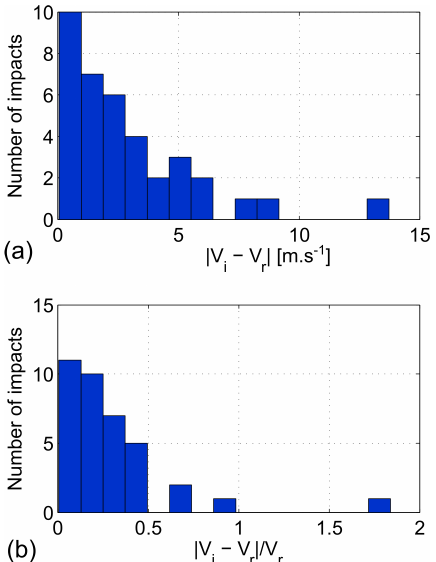
Figure 5. (a) Histogram showing the distribution of the differ- ence between the velocity before impact V i inferred using Eqs. (7) and (8) and the velocity V r estimated from the video cameras. (b) Same as (a) but normalized by the value of the velocity V r esti- mated via the video